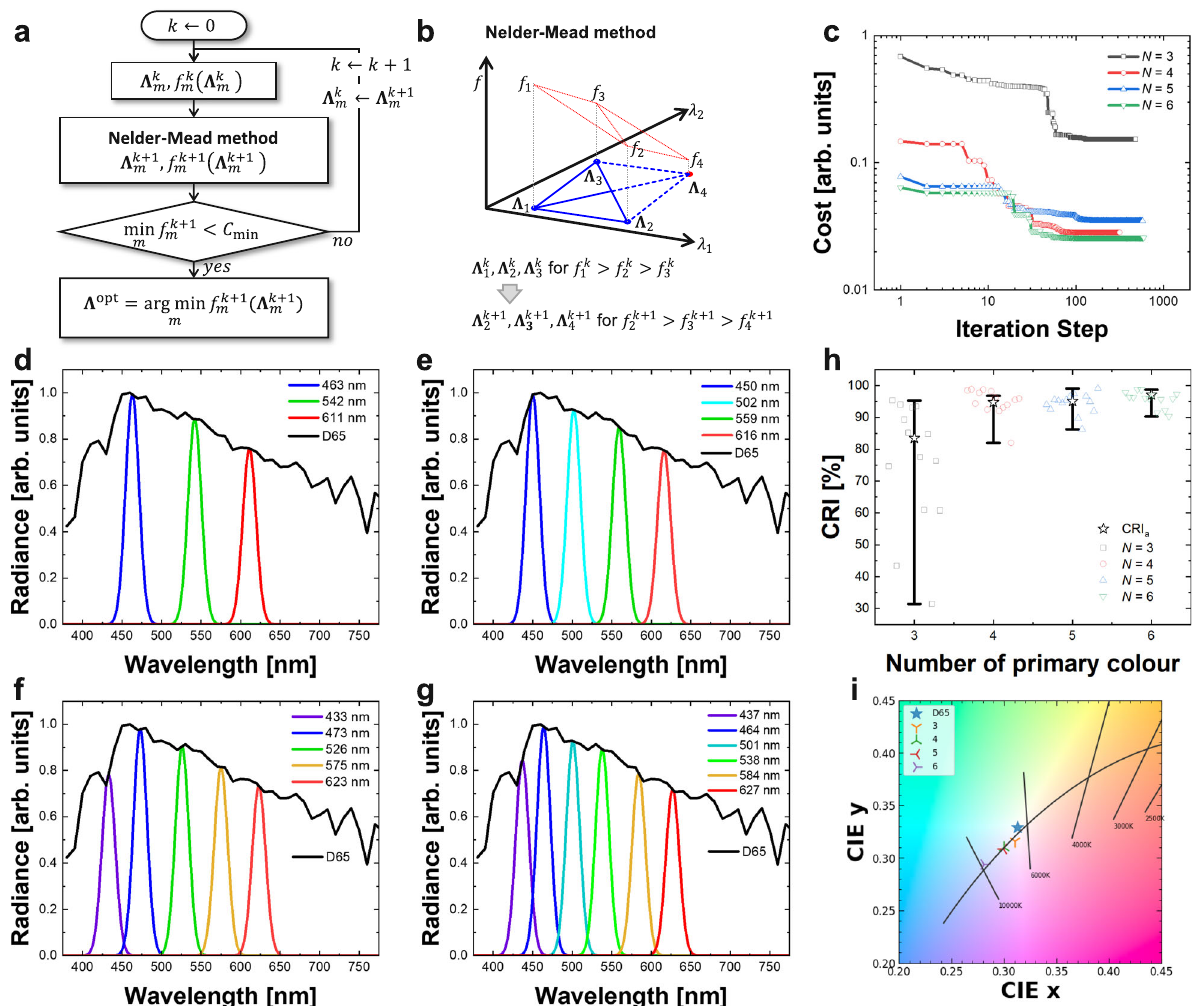
Fig. 2 Optimal emission spectra of multi-primary lightings designed by the colour optimisation process. a Iterative optimisation procedure determining a peak wavelength set of N -primary lighting. An index for a given iteration step is denoted by k . Λ m k is a m -th peak wavelength set in the group of the peak wavelength sets for the Neler-Mead method, where m ∈ {1, 2, … , N + 1}. f m k ( Λ m k ) is a cost for the given peak wavelength set. ‘ min f m k ’ is a minimum value among the costs f m k , and C min is a criteria of convergence level for stopping the iteration process. ‘ arg min ’ is an argument of the minimum for the cost function. b Schematic illustration of the Nelder-Mead algorithm minimising the cost function. c Convergence plots of the cost functions for N -primary lightings. The cost functions are minimised to have high CRI and chromaticity close to D65 illuminant. d – g Spectra of 3-, 4-, 5-, and 6-primary lightings for their optimised peak wavelength sets. The emission peaks at each peak wavelength are designed to follow the normalised power distribution of the CIE D65 illuminant. h CRI values of N -primary lightings with the optimised peak wavelength sets. Individual CRIs for 14 TCSs are marked with rectangles, circles, triangles, and inverse triangles for the optimised 3-, 4-, 5-, and 6-primary lightings. The average CRI (CRI a ) for TCSs from 1 to 8 and the range of the CRIs are marked with star and minimum/maximum interval plot. i CIE chromaticity coordinates for the 3-, 4-, 5-, and 6-primary lightings designed by the colour optimisation